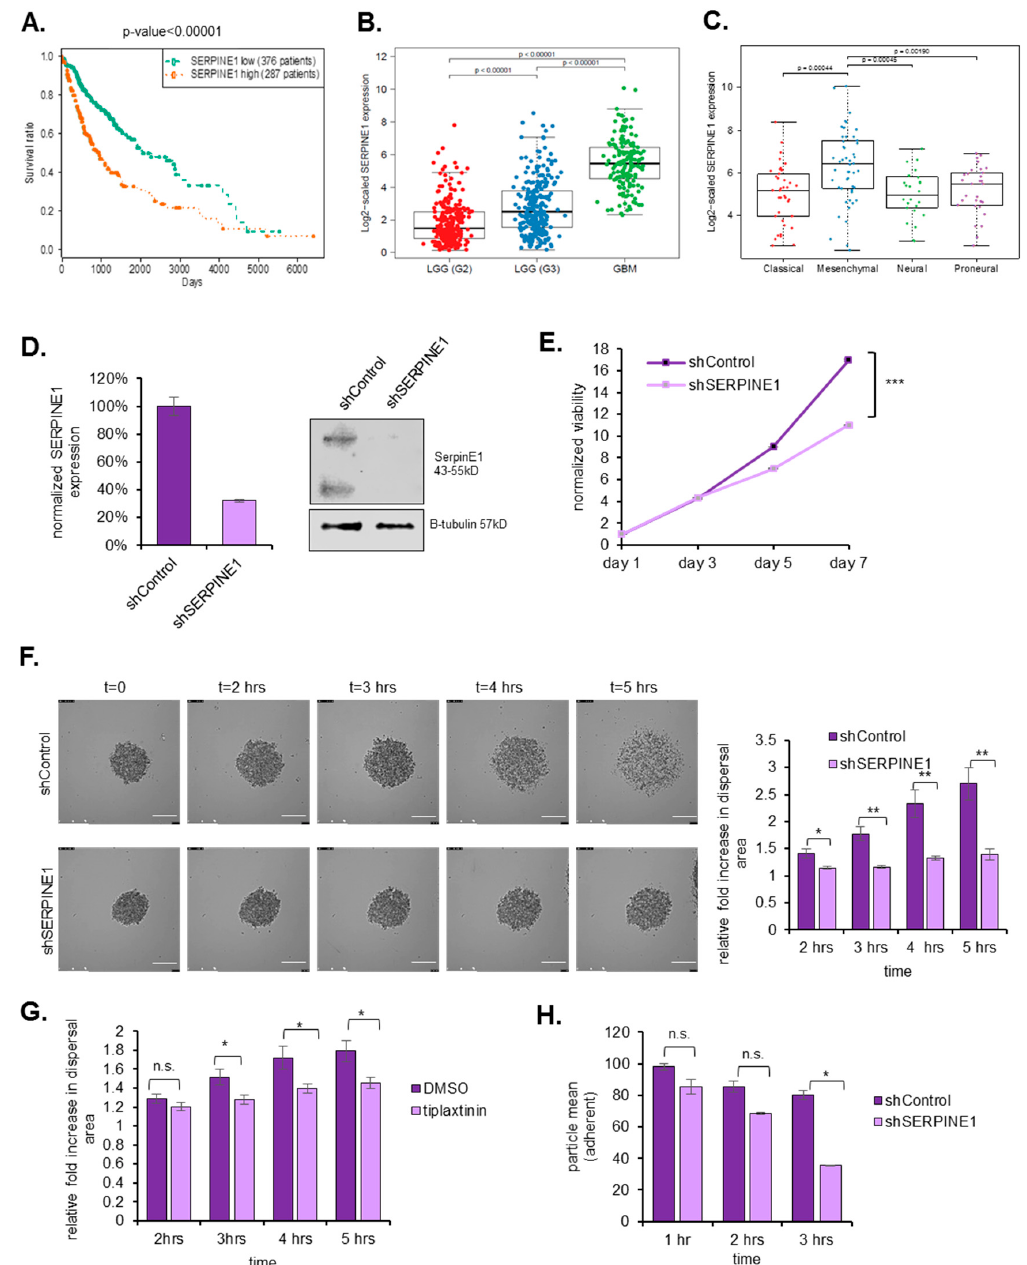
Figure 5. SERPINE1 expression is correlated with poor prognosis and its silencing in a clinically-relevant model reduces cell viability and dispersal. ( A ) TCGA survival data plotted for high / low SERPINE1 expressing glioma patients. ( B ) SERPINE1 expression correlation with LGG samples and GBM samples; ( C ) SERPINE1 expression correlation with GBM subtypes; ( D ) SERPINE 1 mRNA and protein levels after shRNA knock-down in GBM8 cells; ( E ) cell viability assays that show SERPINE1 knockdown slows down GBM8 cell proliferation; ( F ) live cell imaging and analysis of shControl and shSERPINE1 spheroids. SERPINE1 knockdown reduces dispersal of GBM8 spheroids (video for five hours of dispersal, images taken every 5 minutes, scale bar: 200 µm, n = 10 spheroids for each condition); ( G ) live cell imaging analysis of DMSO- or Tiplaxtinin-treated GBM8 spheroids. (video for five hours of dispersal, images taken in every 60 minutes, magnification is 10×, n = 12 spheroids for each condition); ( H ) SERPINE1 knock-down reduces the number of attached cells in different time points (three wells analyzed for each condition and each time point). (*, ** and *** denote p < 0.05, p < 0.01 and p < 0.001 respectively, two-tailed Student’s t -test).